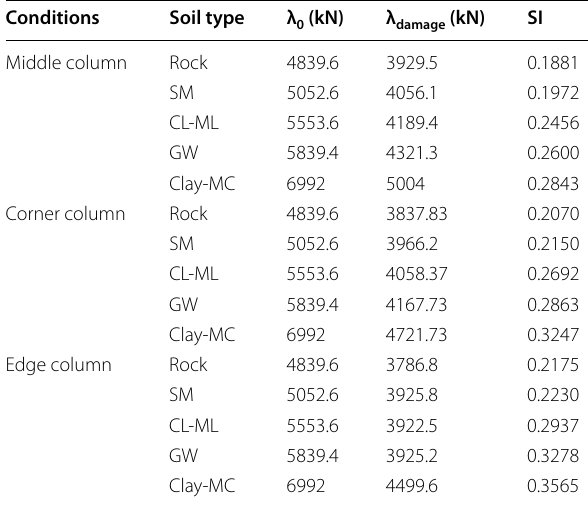
Table 9 Redistribution of the imposed loads in the 20-story RC frames with different soil types.